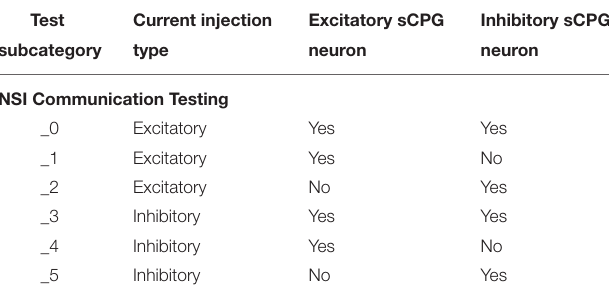
TABLE 2 | Test subcategory code reference.